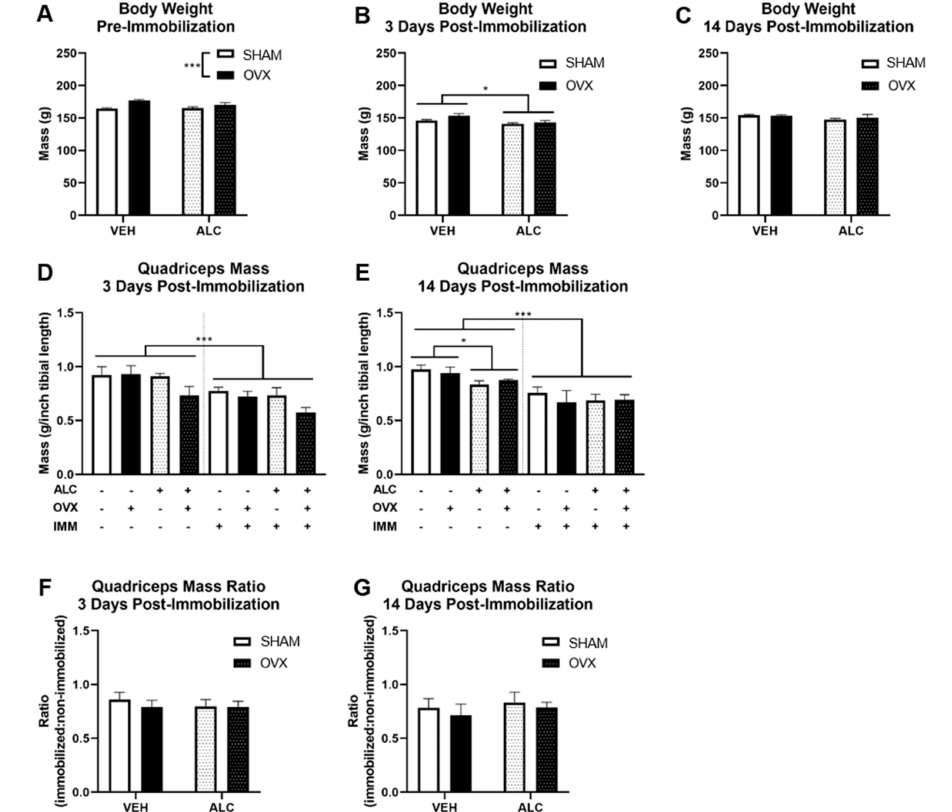
Figure 2. Total body weight before immobilization ( A ) and after 3 ( B ) and 14 ( C ) days of post-immobilization recovery; quadriceps mass relative to tibia length after 3 ( D ) and 14 ( E ) days of post-immobilization recovery, and ratio of immobilized to nonimmobilized quadriceps mass after three ( F ) and 14 ( G ) days of post-immobilization recovery. Body weight shown at pre-immobilization includes all animals; all other figures depict the three- or 14-day post-immobilization recovery groups. Body weights and quadriceps mass ratios were analyzed using two-way ANOVA (alcohol × ovariectomy). A paired-samples t -test was used to detect di ff erences due to immobilization for quadriceps weight relative to tibia length. Then, treatment e ff ects were analyzed using two-way ANOVA (alcohol × ovariectomy) for the nonimmobilized and immobilized hind limbs separately. VEH: pair-fed, ALC: alcohol-fed, SHAM: nonovariectomized, OVX: ovariectomized, IMM: immobilized. “ + ” indicates that it includes that treatment; “ − “indicates that it does not include that treatment. * p < 0.05, *** p < 0.001. Means ± SEM. N = 4-5 per